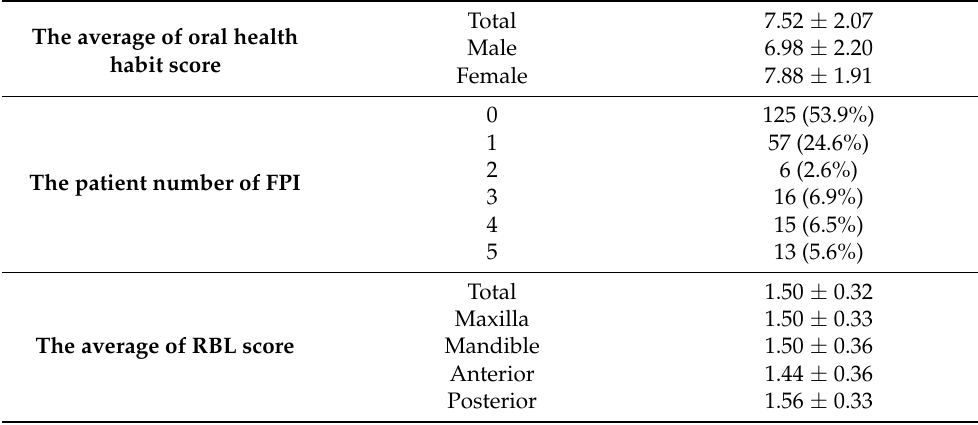
FPI: fluorescent plaque index; RBL: radiographic bone